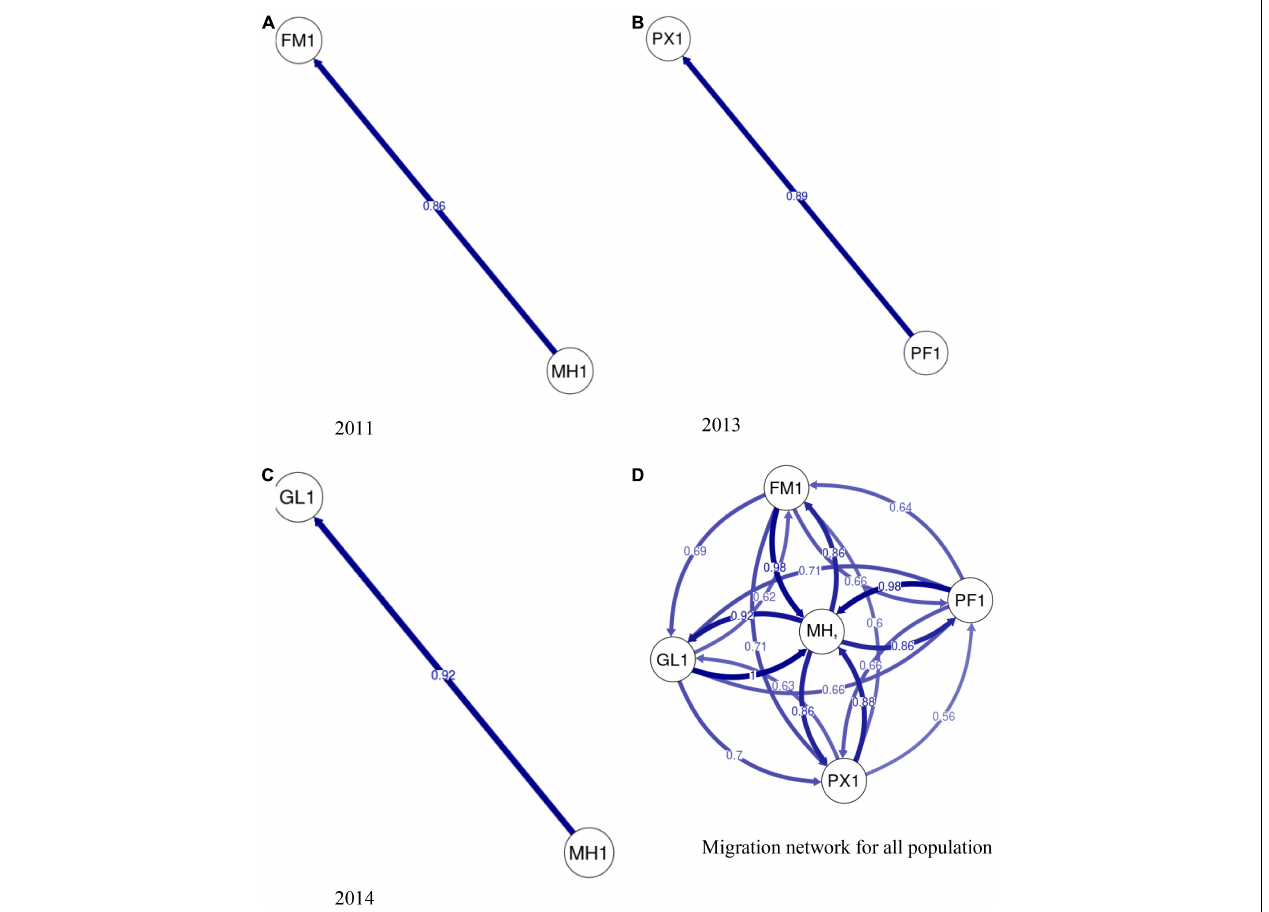
FIGURE 3 | Directional relative migration network for sampled bigeye tuna.Directional relative migration estimated by divMigrate-online using Nm migration statistic. Arrows indicate the direction of gene flow and numbers show relative migration coefficient. Arrows with higher numbers appear thicker and stronger in color. Spatial relative migration estimated between (A) FM and MH in 2011 (B) PX and PF in 2013. (C) GL and MH in 2014. (D) Illustrates the calculated migration values, with no filter threshold, for all populations sampled. Temporal samples from Marshall Islands were pooled into a single population to estimate migration network for all populations. TABLE 5 | Pairwise F ST values (above diagonal) and associated P -values (below diagonal) between geographical population samples based on a panel of 26 loci under potential selection (LUPS) obtained from LOSITAN.